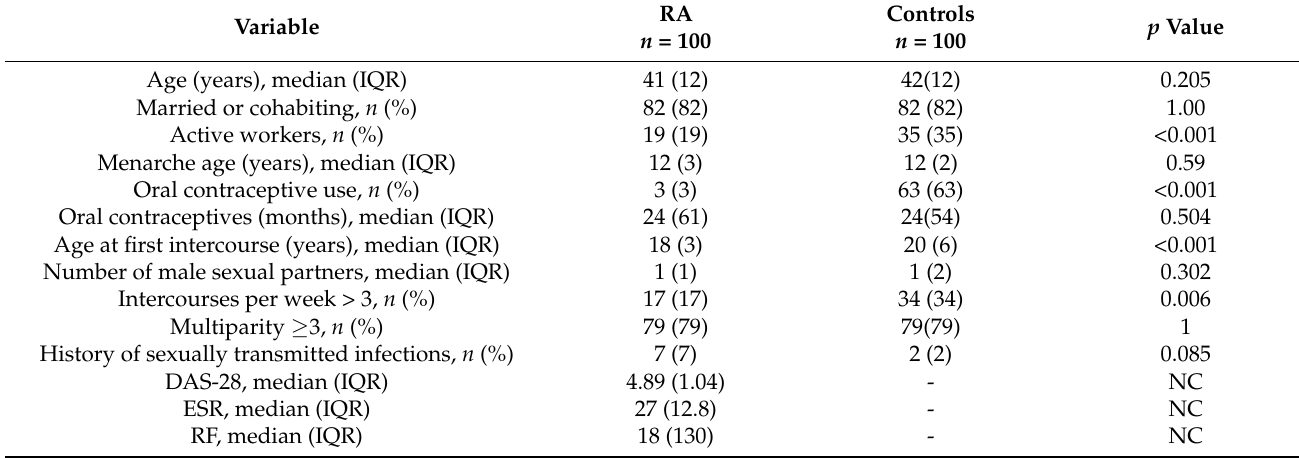
Table 1. General characteristics and sexual history of patients with rheumatoid arthritis and